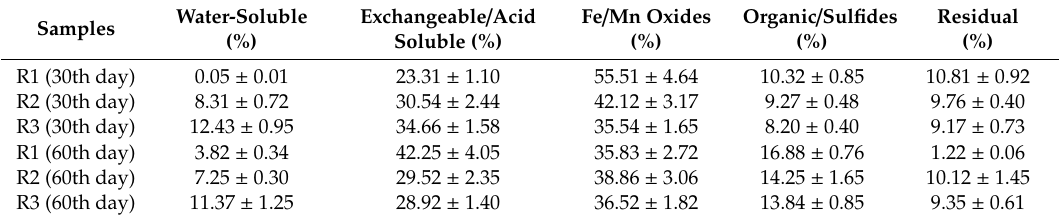
Table 2. Distribution of di ff erent Fe fractions in R1–R3 on the 30th and 60th